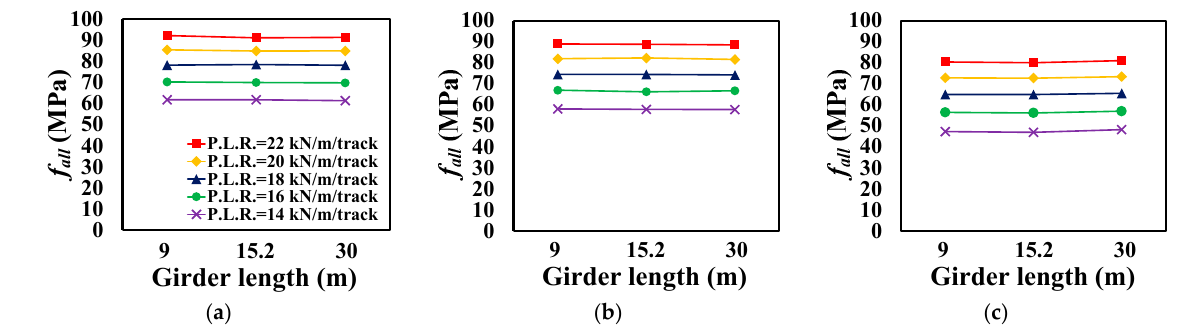
Figure 13. Effect of girder length ( e G = 0): ( a ) R = 1500 m; ( b ) R = 700 m; and ( c ) R = 300 m.